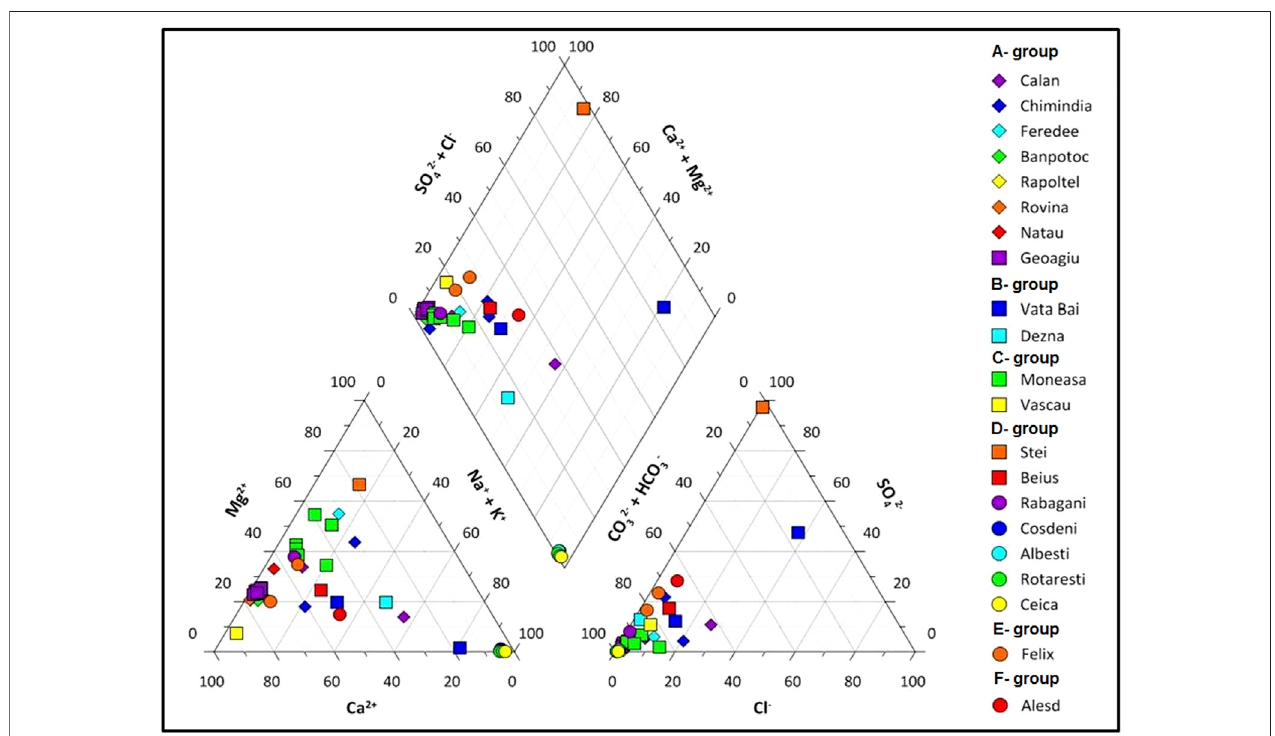
FIGURE 2 | Piper plot showing the hydrochemical type of the investigated